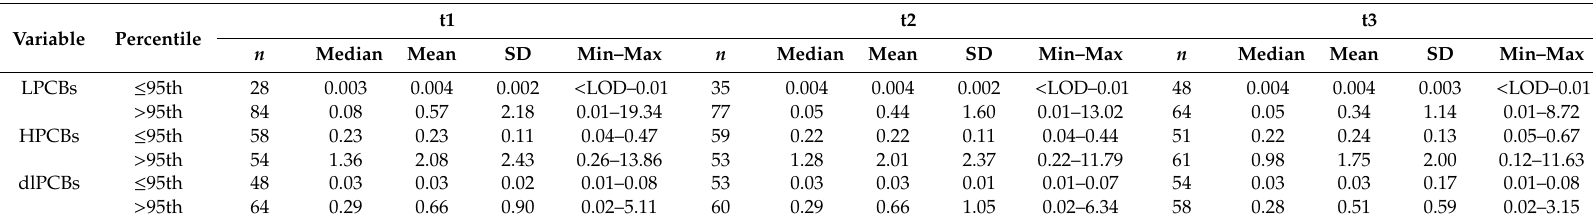
Table 2. Descriptive data of PCB exposure in participants with a PCB background burden and a higher PCB